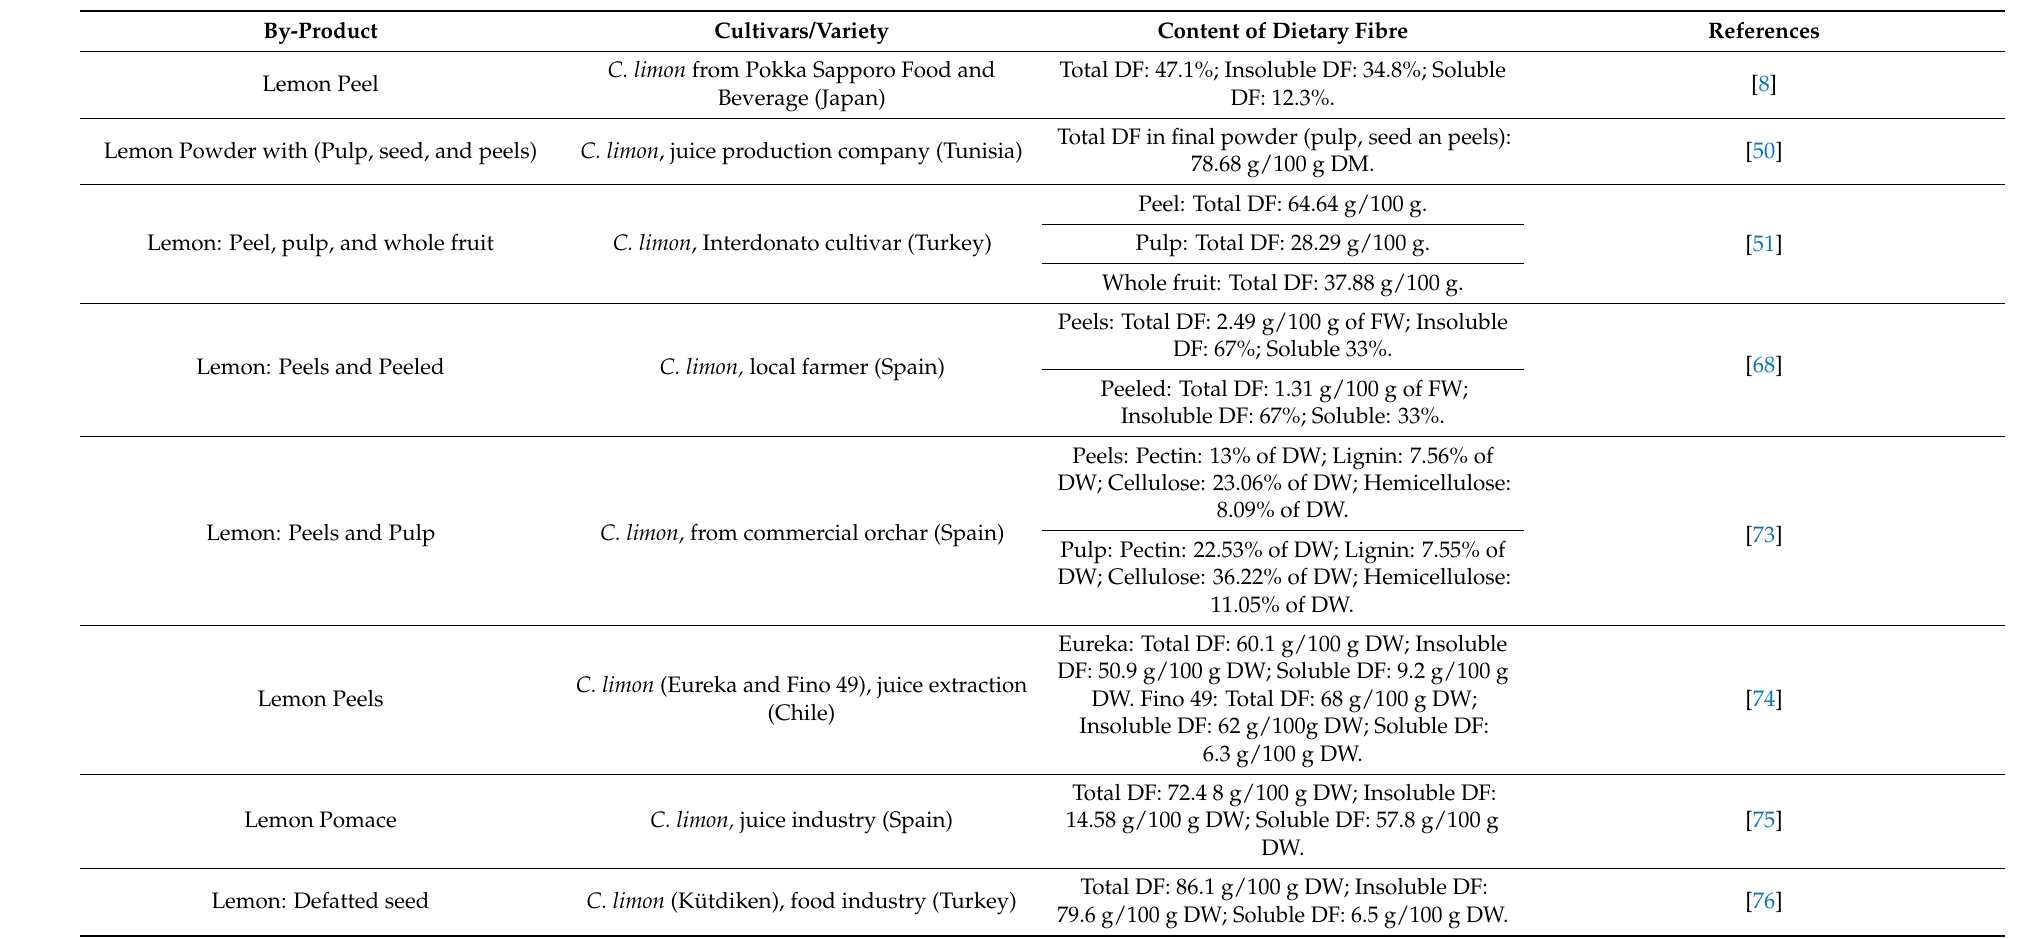
Table 5. Dietary fibre (DF) composition of lemon by-products.